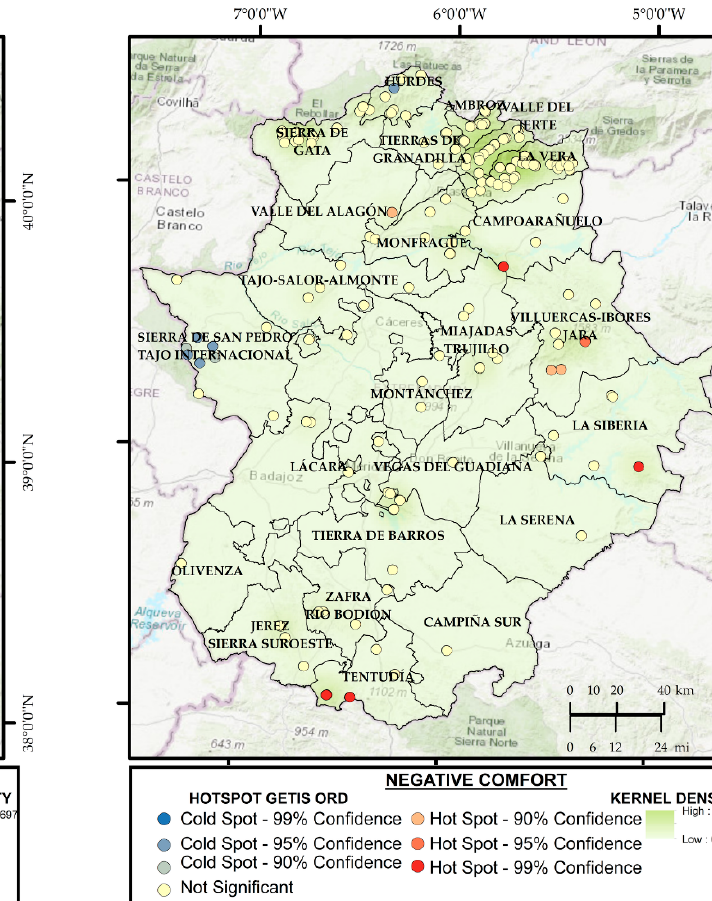
Table 9. G Getis Ord test on Location. Type of mention